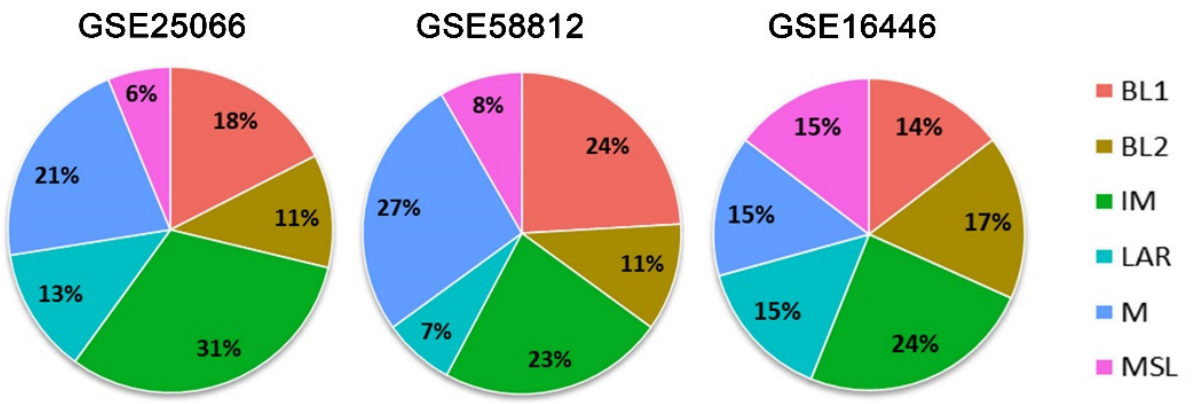
Figure 1. Distribution of Triple Negative Breast Cancer subtypes in each dataset, GSE25066 ( n = 80), GSE58812 ( n = 83) and GSE16446 ( n = 41). Abbreviations: basal-like 1 (BL1), basal-like 2 (BL2), immunomodulatory (IM), mesenchymal (M), mesenchymal stem-like (MSL), and luminal androgen receptor (LAR).